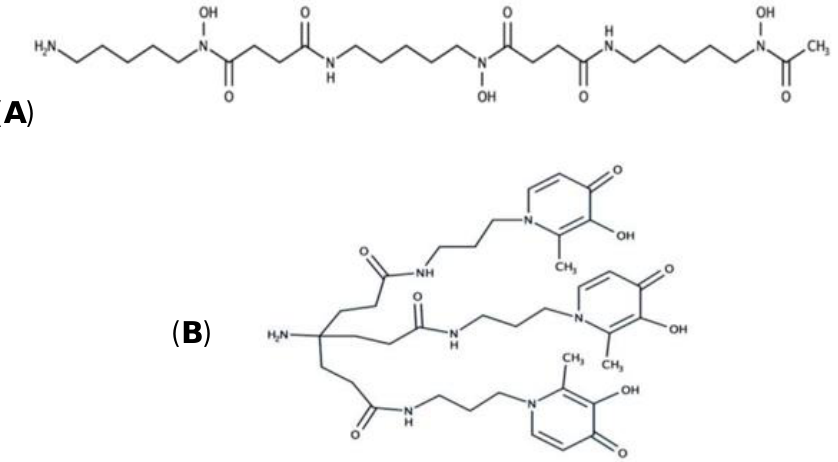
Figure 15. ( A ) Deferoxamine ( B ) 3,4-hydroxipyridinone structures. (Adapted with permission from [39], open access Creative Common CC licenced 4.0, MDPI).